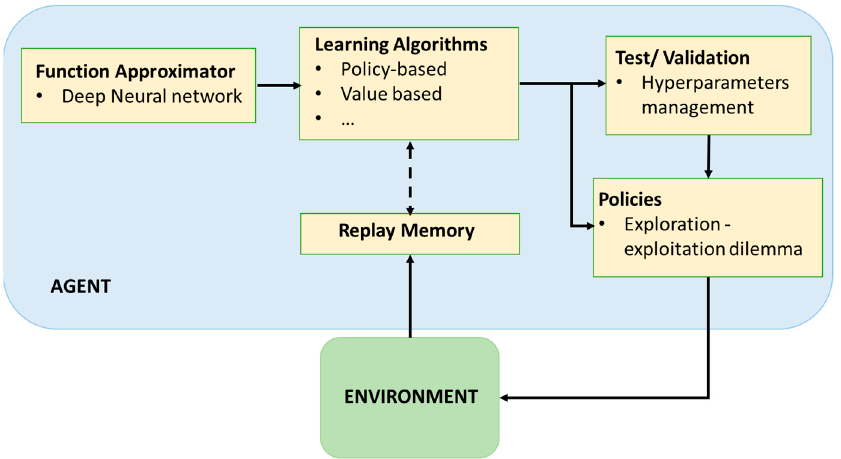
Figure 3. The general architecture of DRL.